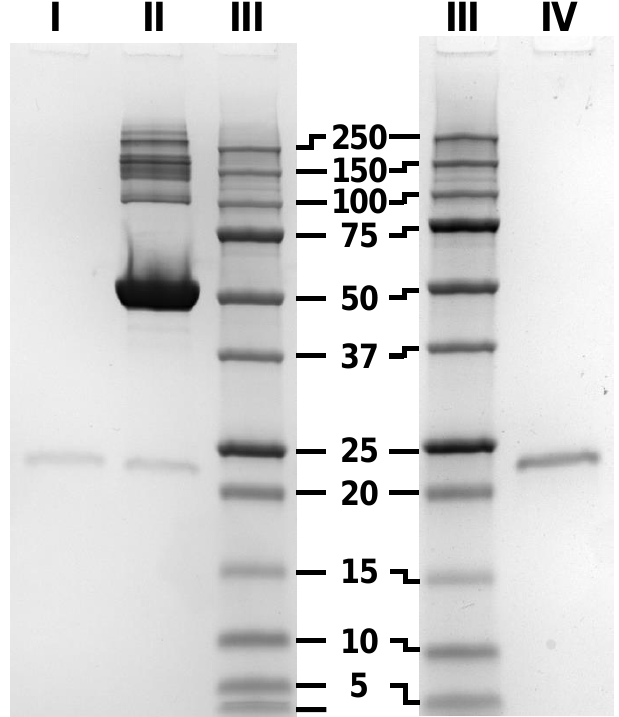
Figure 4. Representative Coomassie brilliant blue stained SDS-PAGE. I = 125 ng BMP-2, II = I + 30 µg BSA, III = Ladder, IV = 500 ng BMP-2.